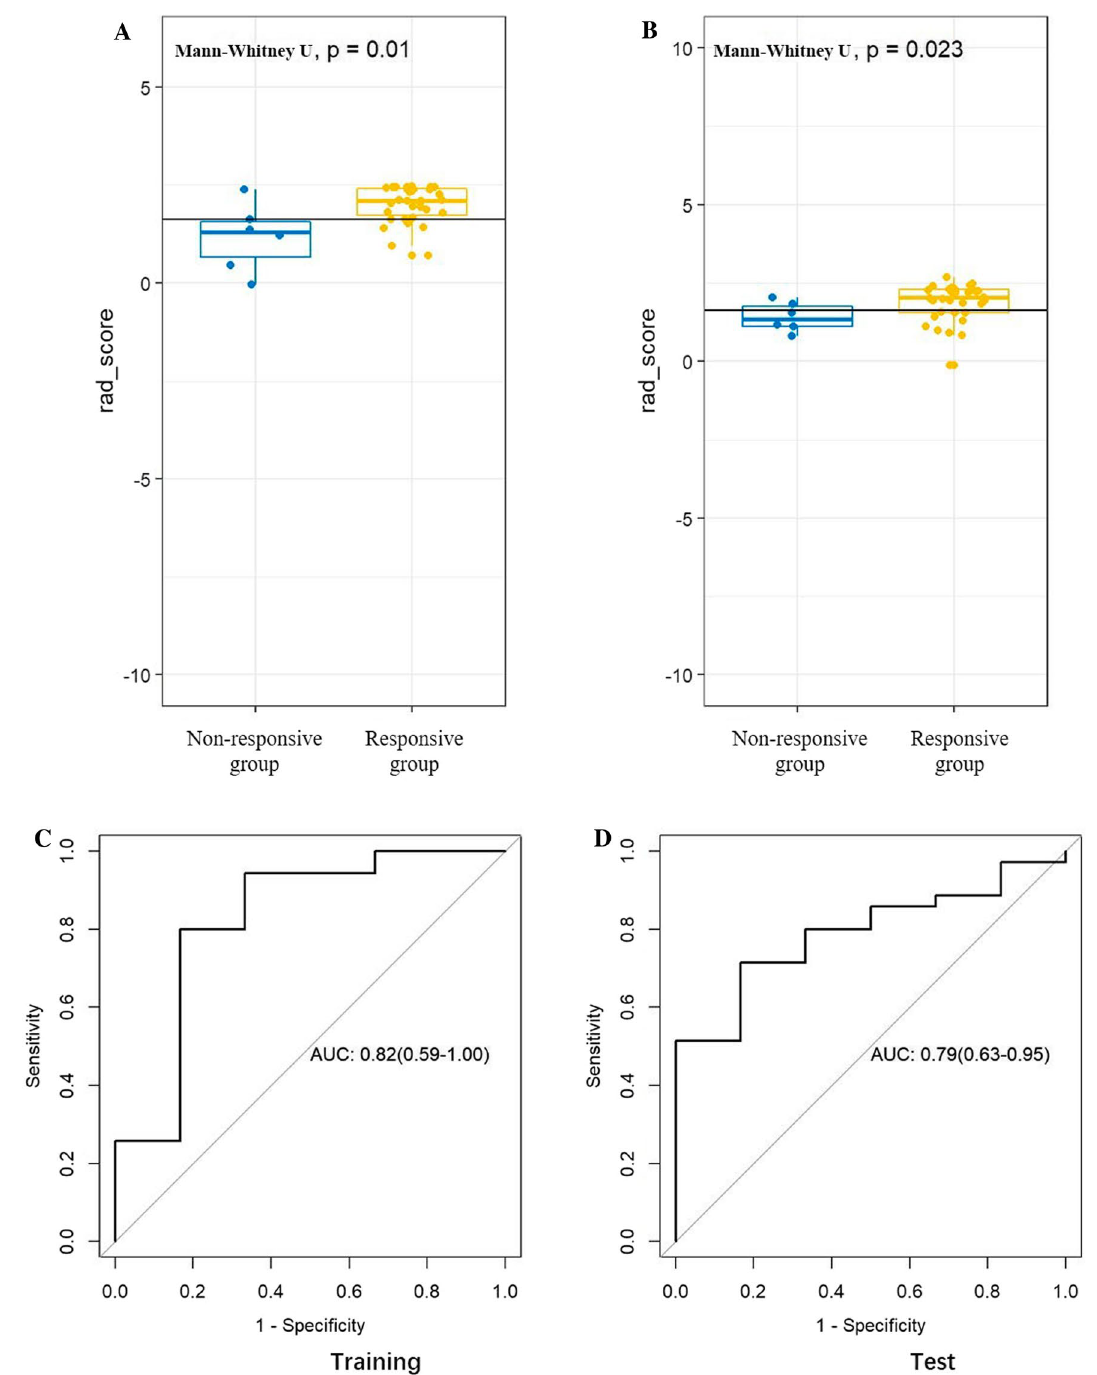
Fig. 3 The radiomics score between responsive group and non-responsive group for each patient in the training set ( A ) and test set ( B ). ROCs of radiomics model for predicting response to nCT on training set ( C ) and test set ( D )